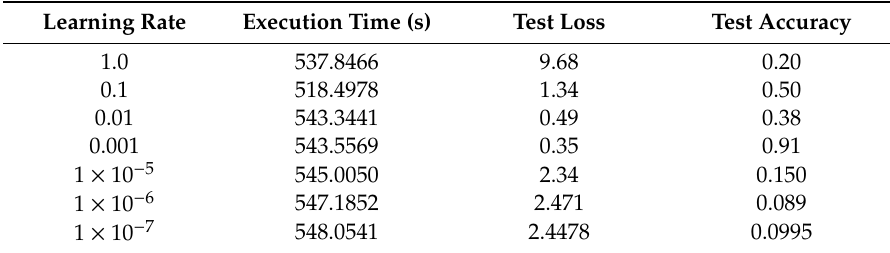
Table 12. E ff ect of learning rate on RNN.